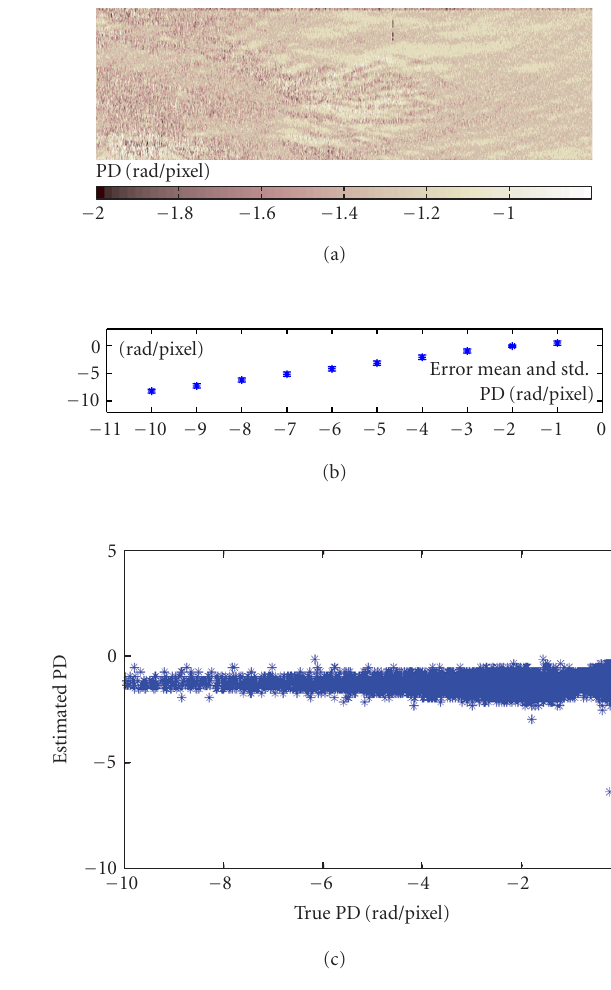
Figure 9: The same as Figure 8, but with the application of the CB with respect to the true DEM.